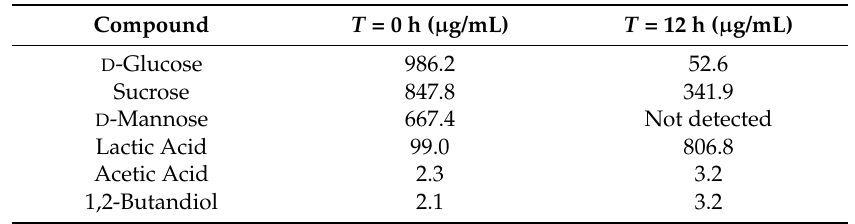
Table 3. Loading plot: compounds driving the changes during fermentation (T = 40 ◦ C, 12 h) of 8% pre-treated millet (1 h, 85 ◦ C) in